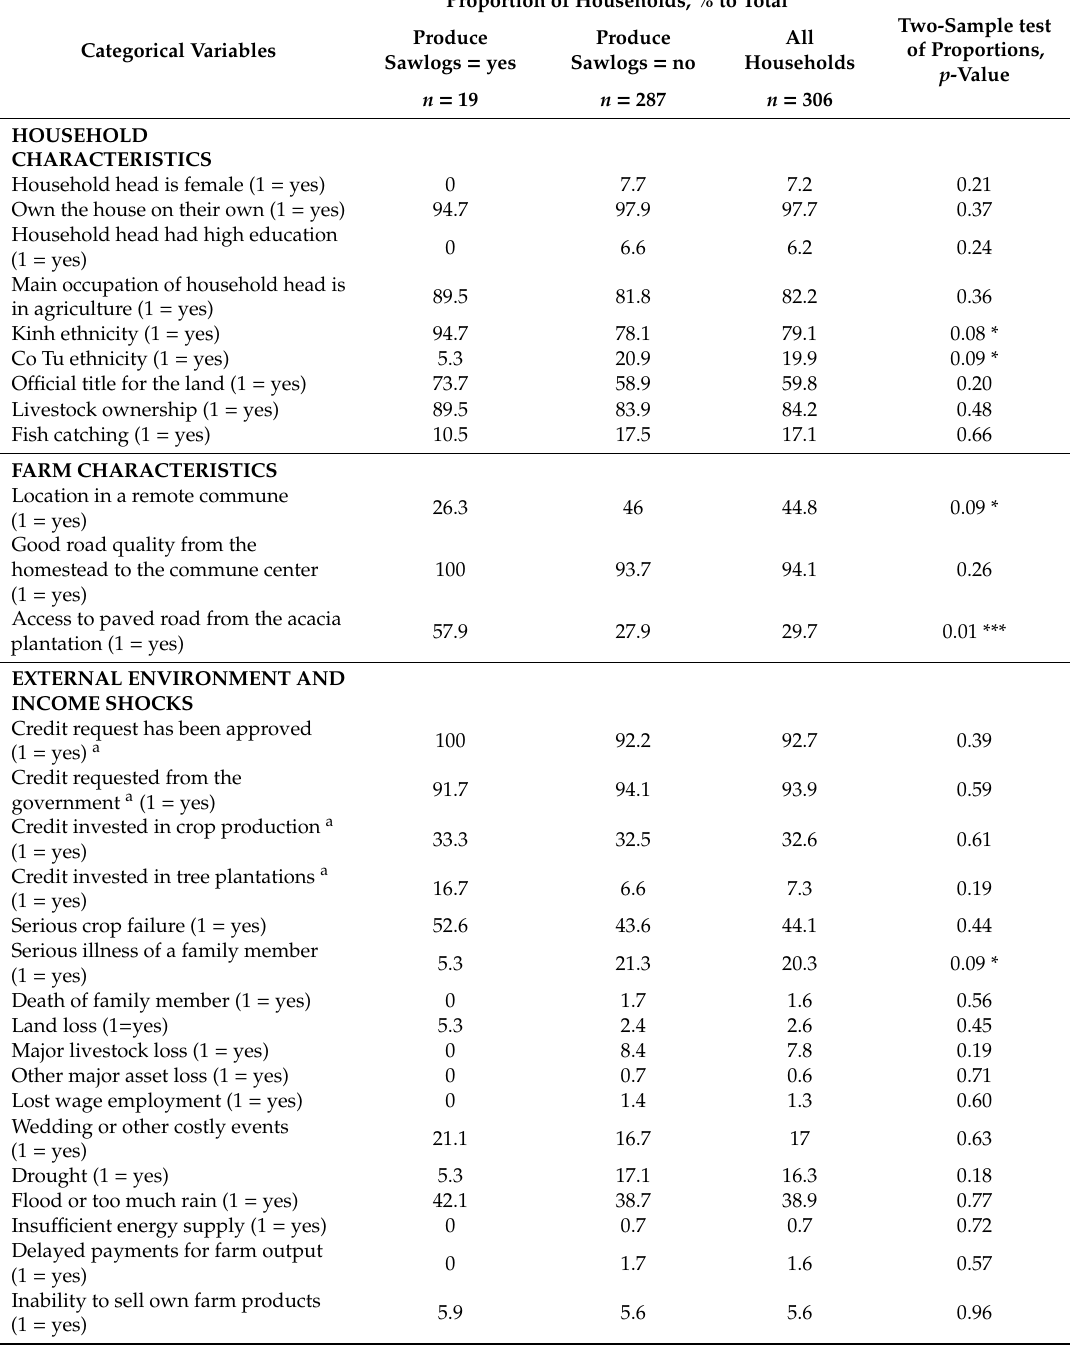
Table 3. Di ff erences between forest owners who produce and who do not produce sawlogs: categorical